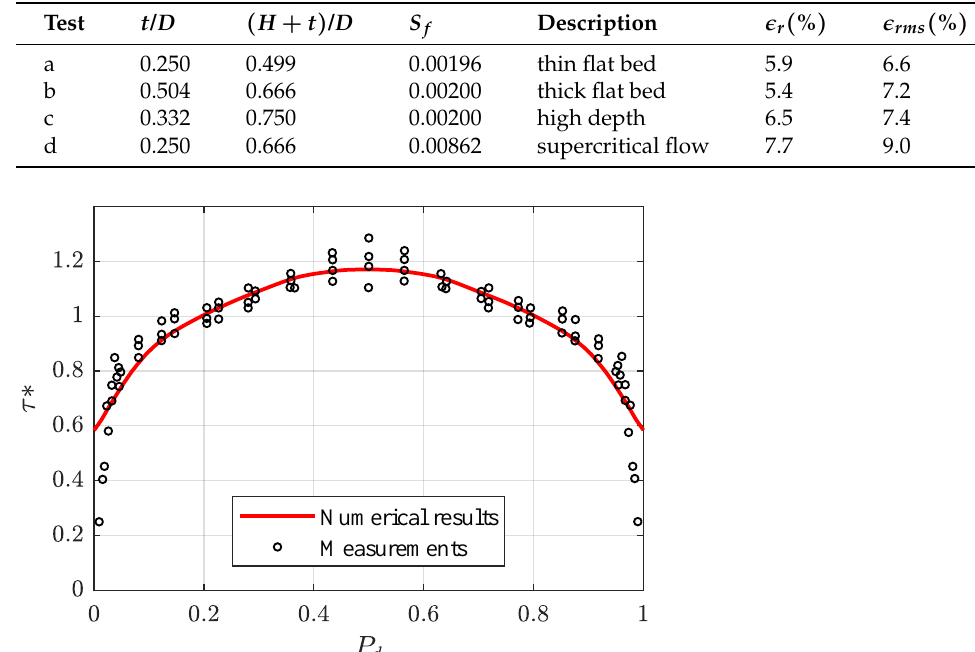
Table 2. Model behavior for flat bed cases by Knight and Sterling [31].